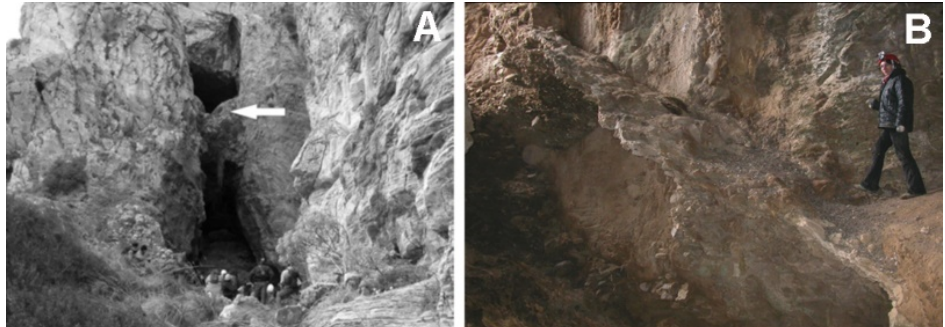
Figure 12. ( A ) The Donnavilla Cave; the hanging speleothem in the upper part of the entrance arrowed. ( B ) The speleothem inside the Cave, overlying a partly eroded bone breccias. A belt of not abraded densely distributed Lithophaga boreholes, pierce both cave walls near the entrance and the cliff outside the cave between 75 and 90 m [46,51]. According to Refs. [52,53] a thick detrital deposit containing irregularly scattered fossil remains of mammals almost sealed the cave. Nowadays, scattered remnants of the bone breccia plaster the bored walls in the outer portion of the cave, while large blocks of the breccia are preserved at the base of the cave’s eastern wall and in the innermost sector. The mammal assemblage may be attributed to the Maccagnone FC for the presence of Dama carburangelensis, C. elaphus siciliae , H. pentlandi and Ursus cf. arctos [53–56]; it was correlated with mammal assemblages from the Tyrrhenian gravels of Rocca Scodonì [40]. In the inner part